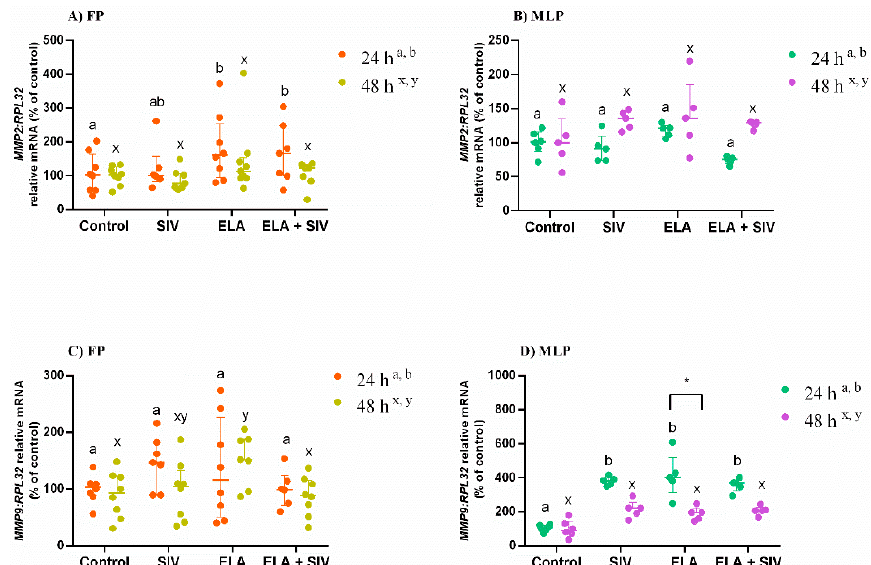
Figure 2. Relative mRNA transcription of matrix metallopeptidase 2 ( MMP2 ) ( A , B ) and MMP9 ( C , D ) in follicular phase (FP) and mid-luteal phase (MLP) mare endometrial explants treated for 24 or 48 h with medium alone (control), elastase (ELA: 0.5 µg/mL), sivelestat (SIV: 10 µg/mL), or ELA (0.5 µg/mL) + SIV (10 µg/mL). Data are shown as median with interquartile range. Results were considered significant at p < 0.05. Different superscript letters indicate significant differences between treatments within each treatment time (a,b—24 h; x,y—48 h). Asterisks indicate statistical differences between times of treatment for the same treatment (* p < 0.05).